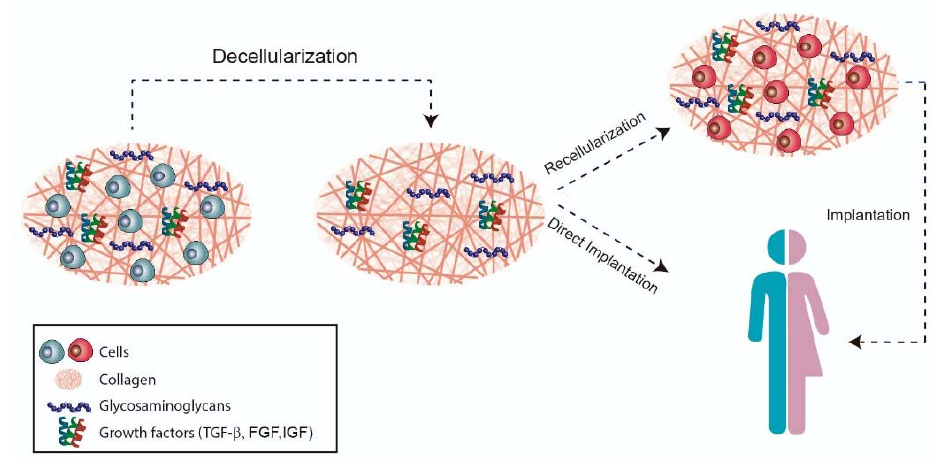
Figure 4. Decellularization